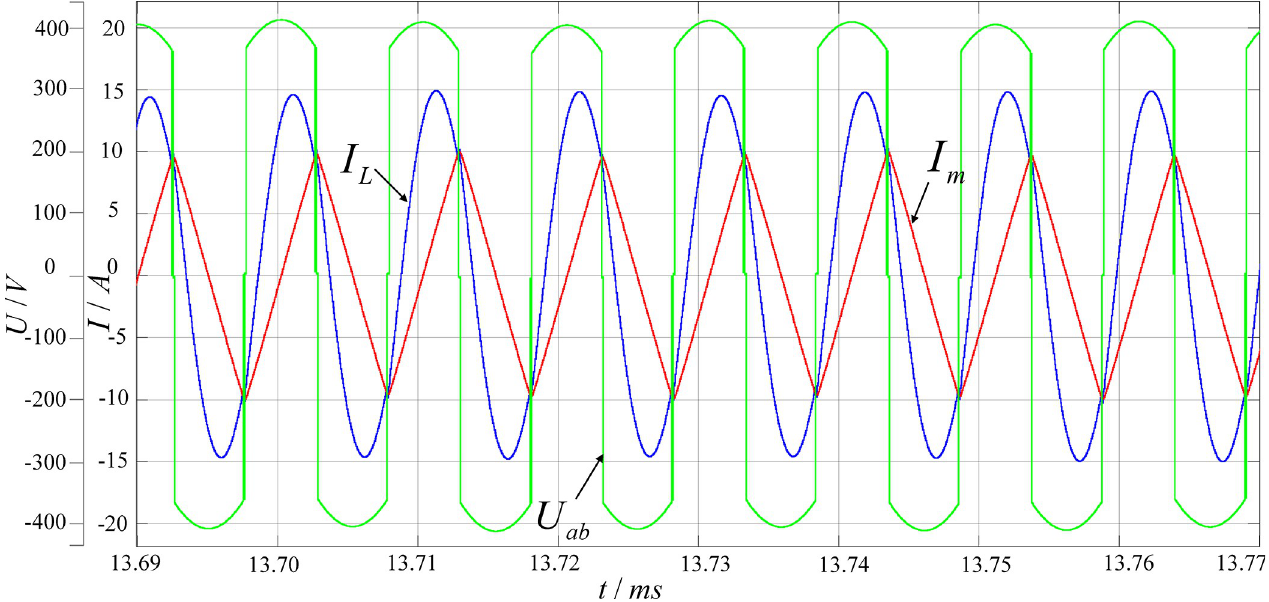
Fig 20. Voltage and current waveforms of the resonant cavity at full load.